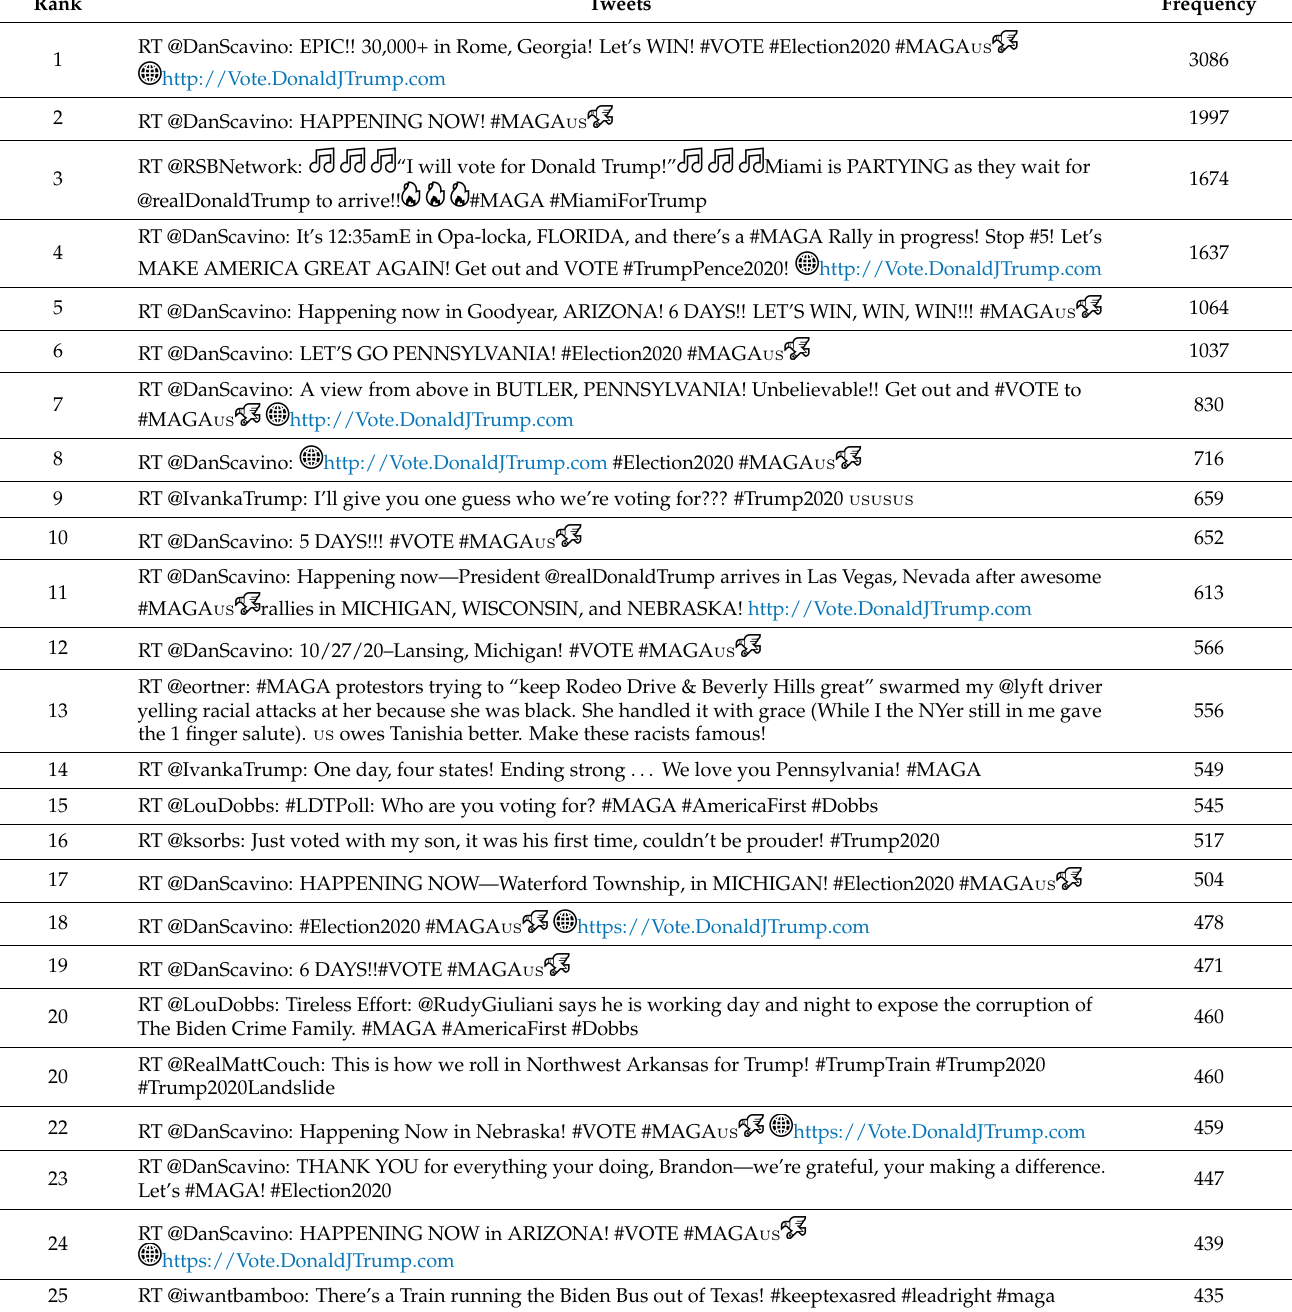
Table 5. The 25 most retweeted tweets.